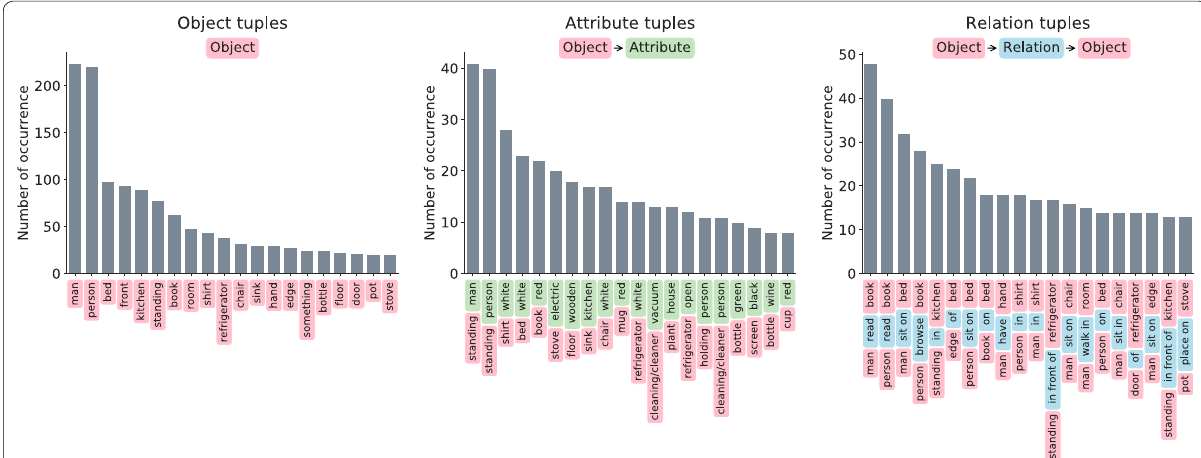
Fig. 8 Three types of top-20 frequent semantic tuples of our dataset. Same as in SPICE [30] described in Sect. “Evaluation metrics”, the “object”-, the “attribute”-, and the “relation”-elements are parsed from a set of reference captions, and they form the three types of tuples lined as the bins. As seen in “relation” frequency (right), our dataset contains several phrases related to the interaction between a person and household